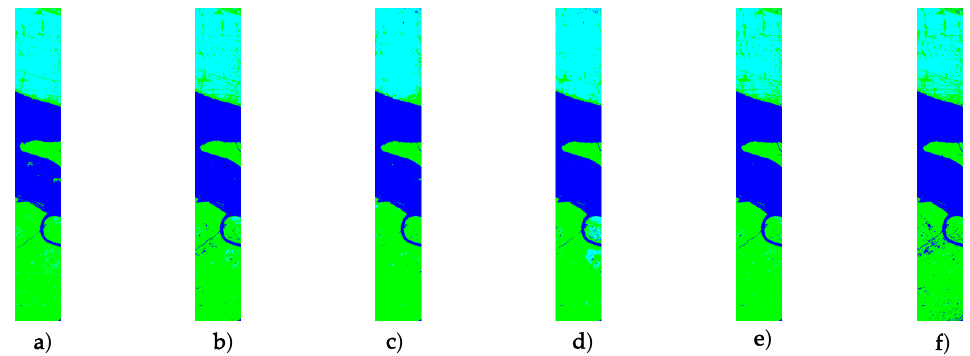
Figure 9. The classification maps of different methods on Hangzhou → Shanghai dataset. (a) Yang et al. method. (b) Mei et al. method. (c) Wang et al. +FT method. (d) First-Stage + FT method. (e) TDDA method. (f) Original map. Table 10. Training and test time for each method in four cases.